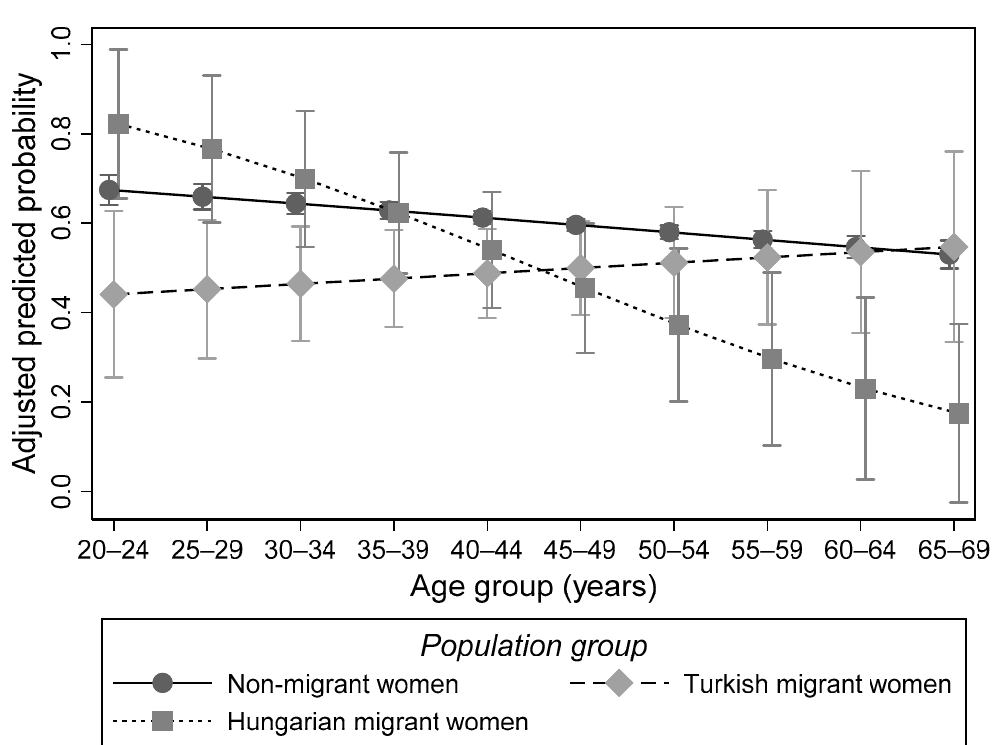
Figure 1. Probability of the utilization of cervical cancer screening by population group and age. Results of the multivariable logistic regression model with the utilization of cervical cancer screening in the last 3 years as the dependent variable and interaction effects between age and population group. Predicated probabilities (Austrian Health Interview Survey 2019; women aged 20–69 years; n = 6228).